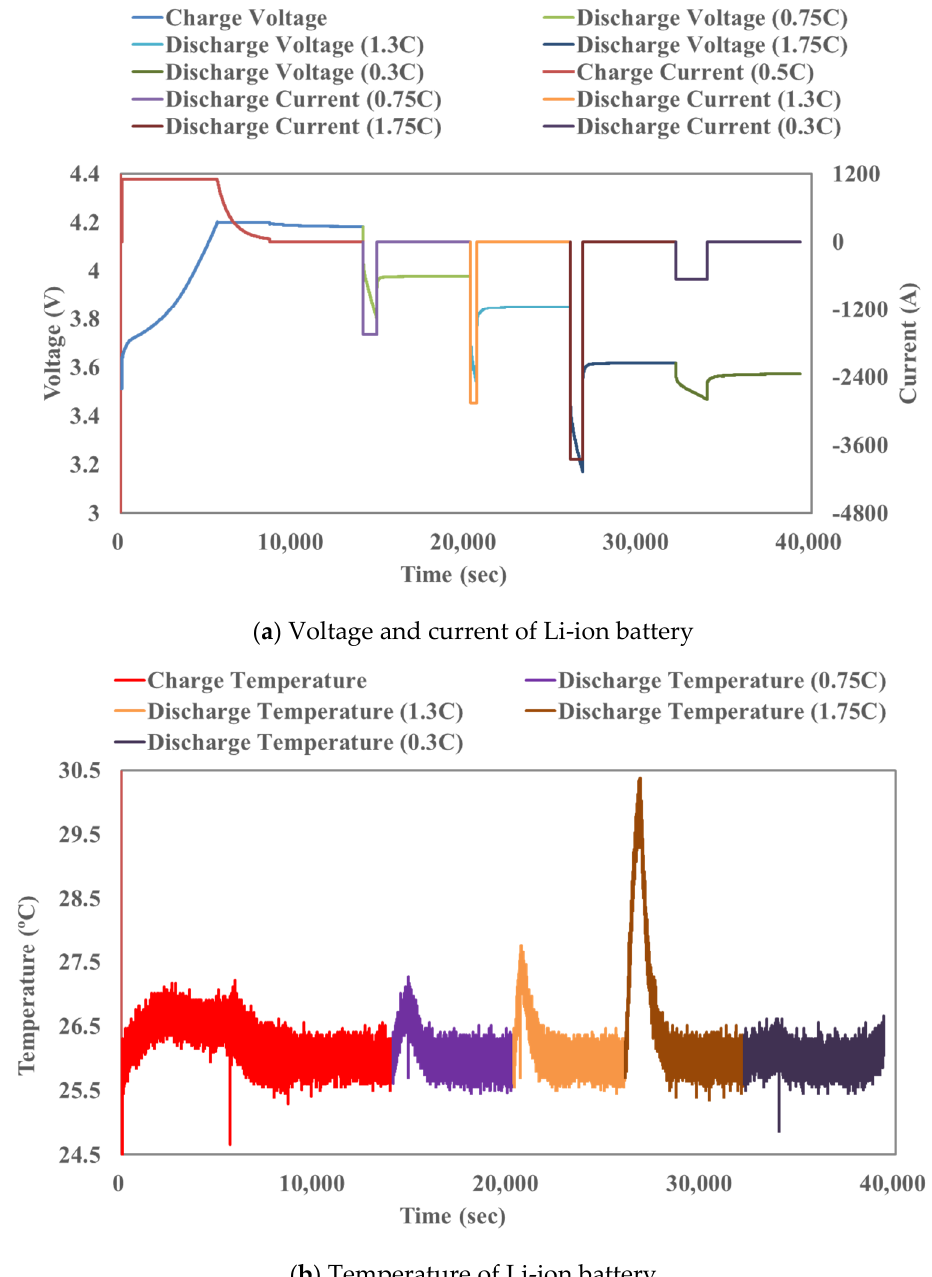
Figure 8. Voltage, current, and cell surface temperature for CC/CV charging and four sets of random discharging.